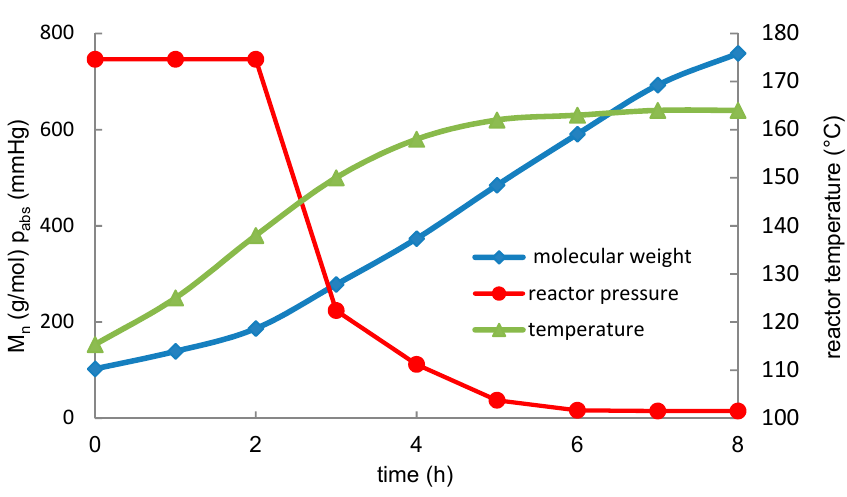
Figure 3. Pressure, temperature, and average molecular weight change in time during the autocatalytic oligomerization of lactic acid.